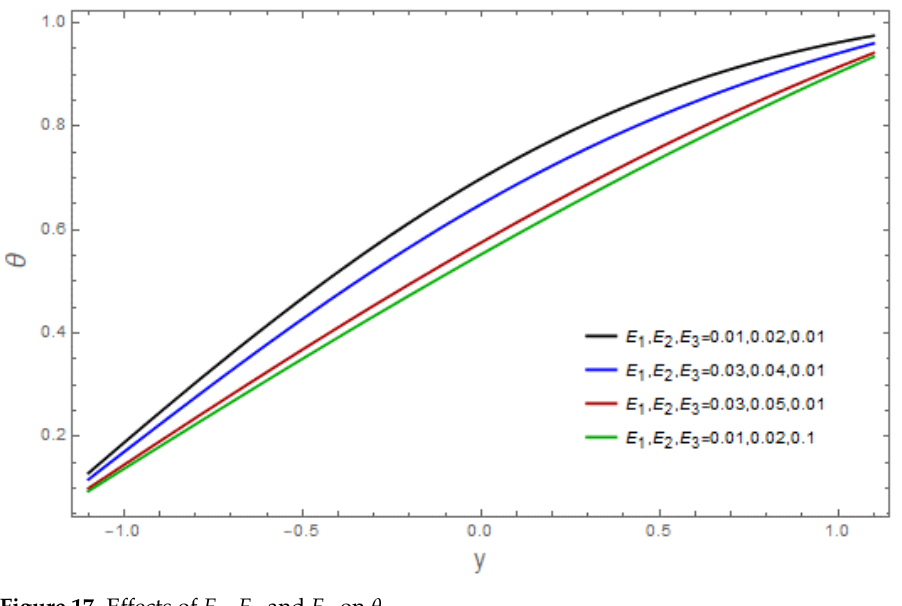
1 , E 2 and E 3 on θ .